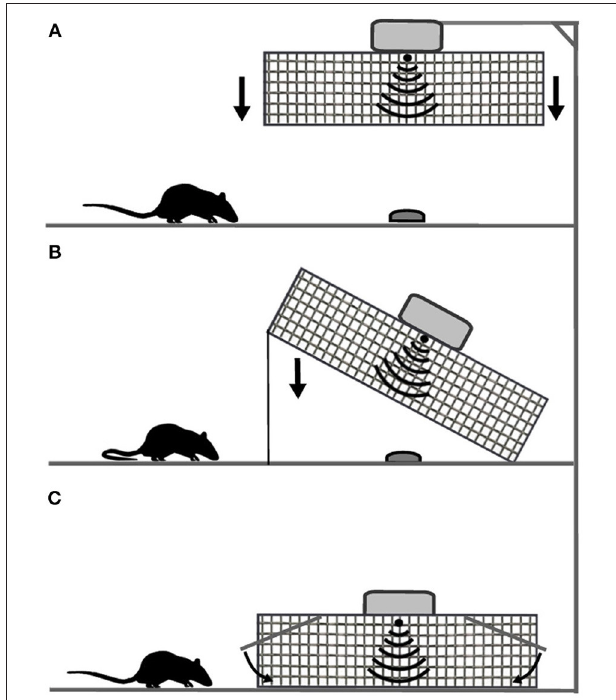
FIGURE 3 | Three ways of implementing the idea: (A) falling transparent cover attached to a rack, ceiling or wall; (B) classic drop trap; (C) classic wire mesh live trap.